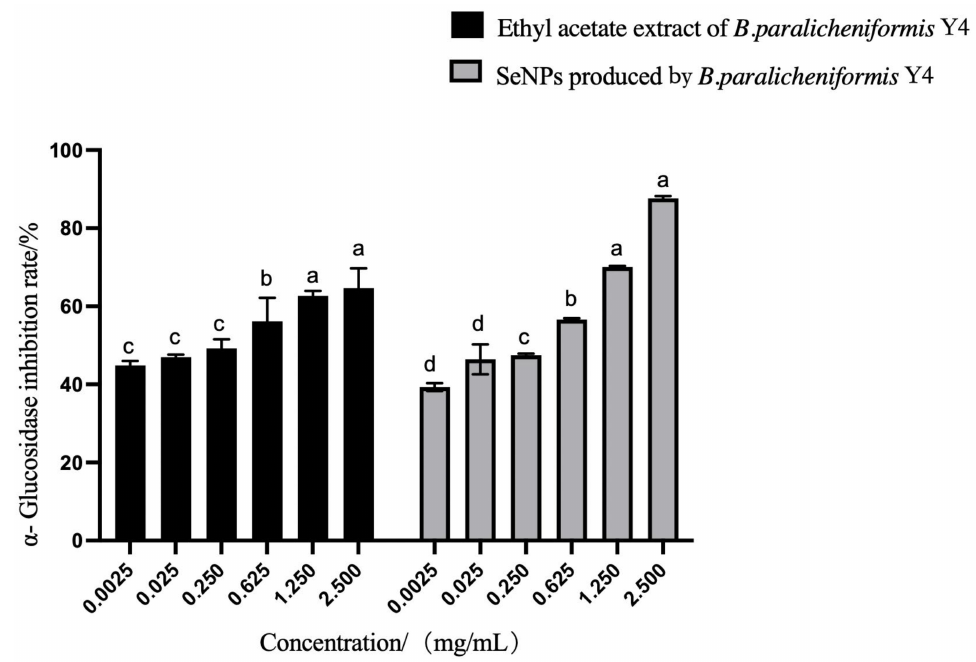
Figure 10. The inhibition rate for a-glucosidase of SeNPs and ethyl acetate extract of strain Y4. The different alphabetic superscripts in the same column are significantly different ( p < 0.05) based on Tukey’s multiple comparison test.